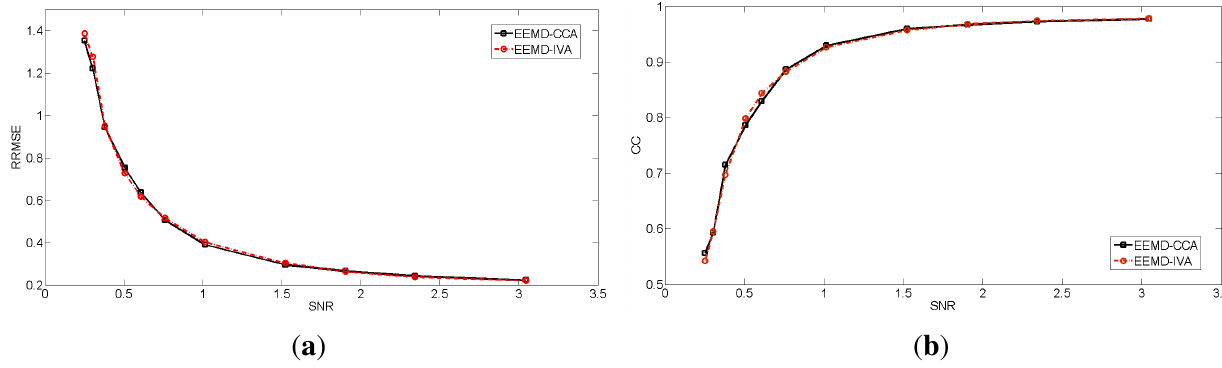
Figure 4. The performance measures for the two EEMD-JBSS methods at different SNR values for the real muscle activity case: ( a ) RRMSE; ( b ) CC.